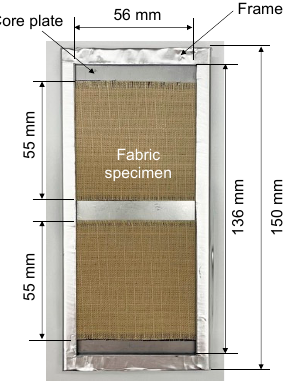
Figure 2. Test specimen placement in the test frame.